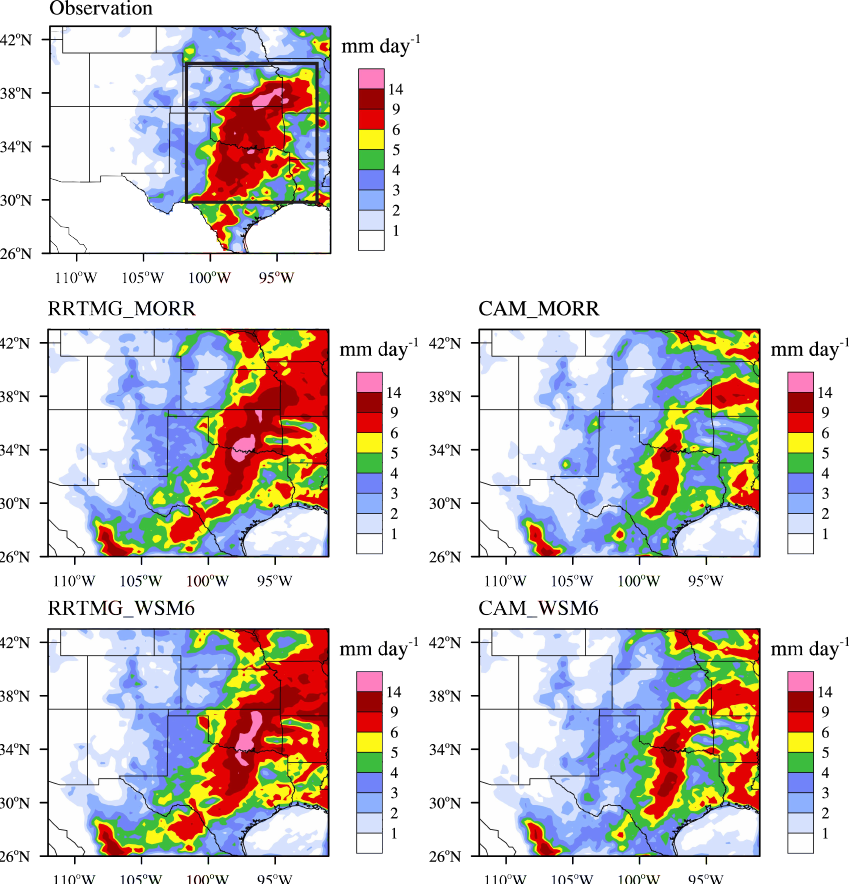
Fig. 3. Spatial distributions of observed and simulated (25km) monthly mean precipitation over SGP for June 2007, with different radiation (RRTMG vs. CAM) and microphysics schemes (WSM6 vs. Morrison). Solid box highlighted in top panel shows the sub-region for later